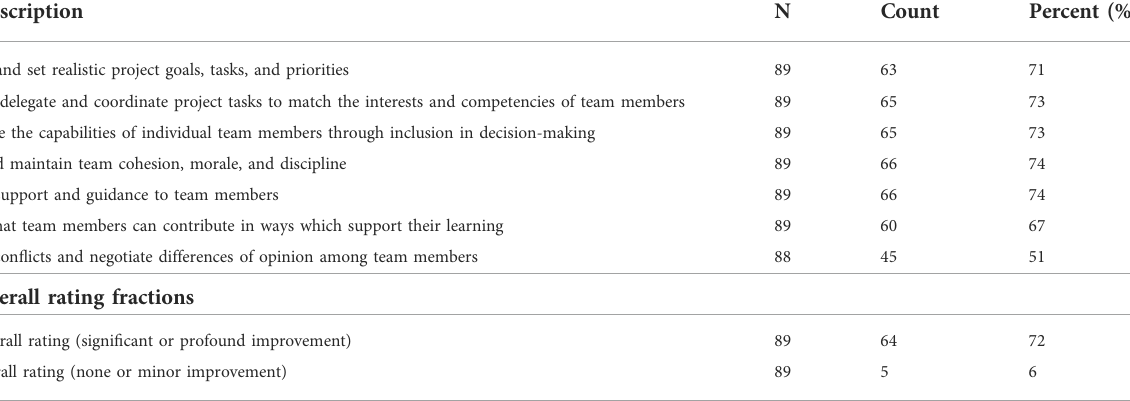
TABLE 3 Leadership skills development. Participants were asked to rate the improvement in their ability to complete tasks associated with leadership. The rating options were none, minor, moderate, signi fi cant, and profound. (A) Fraction of respondents who rated their